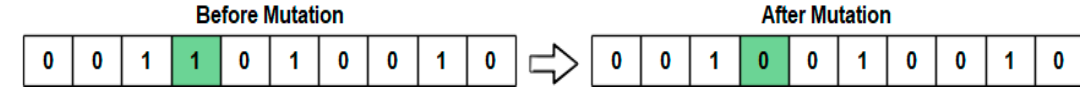
Figure 5. One-point mutation. Figure 5. One-point